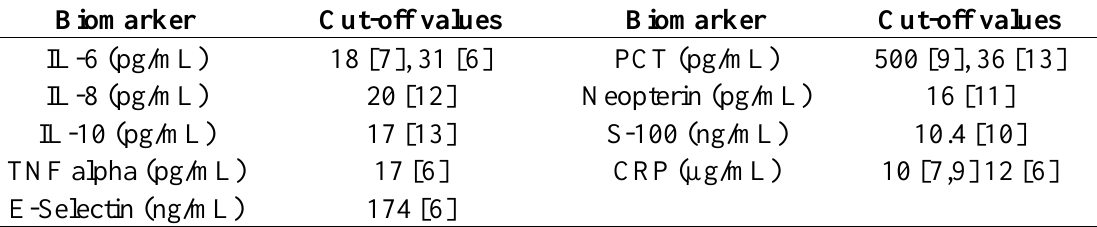
Table 1. Cut-off values for the respective